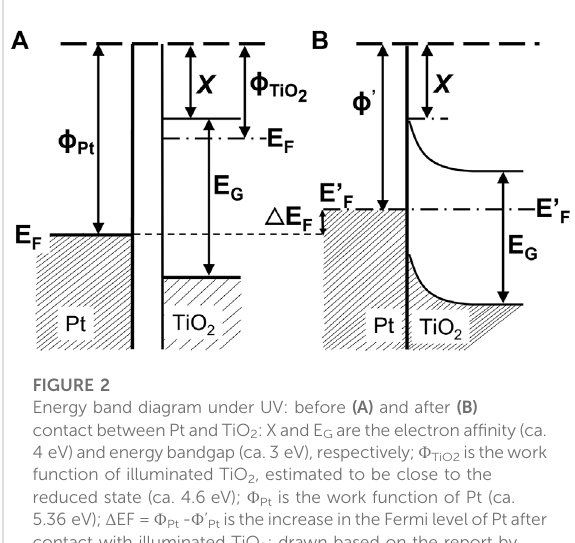
FIGURE 2 Energy band diagram under UV: before (A) and after (B) contactbetweenPtandTiO 2 :XandE G aretheelectron af fi nity(ca. 4 eV)andenergybandgap(ca.3 eV),respectively; Φ TiO2 isthework function of illuminated TiO 2 , estimated to be close to the reduced state (ca. 4.6 eV); Φ Pt is the work function of Pt (ca. 5.36 eV); Δ EF= Φ Pt - Φ ’ Pt istheincreaseintheFermilevelofPtafter contact with illuminated TiO 2 ; drawn based on the report by Disdier et al.,